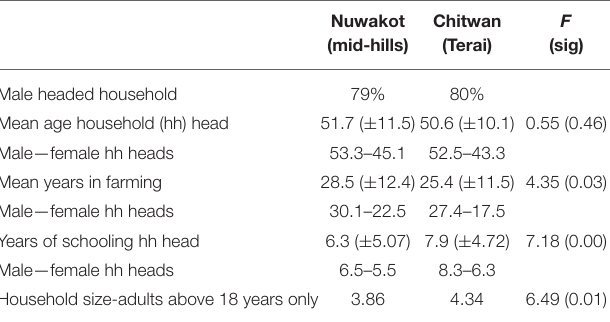
TABLE 2 | Socioeconomic information of households in study areas, Nepal. TABLE 3 | Paddy yield and area in study areas, Nepal (kg paddy/ha,